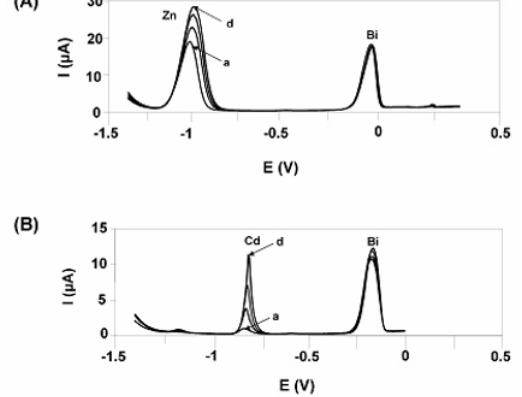
Figure 3. Measurements of (A) Zn( ΙΙ ) and (B) Cd( ΙΙ ) in mussel tissue ERM-CRM 668. Square-wave stripping voltammograms show a mussel tissue sample (a) and three standard additions (b - d) of 5 μg L -1 of each metal. Preconcentration potential -1.4 V for a preconcentration time of 180 s; “cleaning” for 30 s at +0.3 V (for the GCE) or at -1.5 V (for the CFE). Other experimental conditions as described in sections 2.5 and